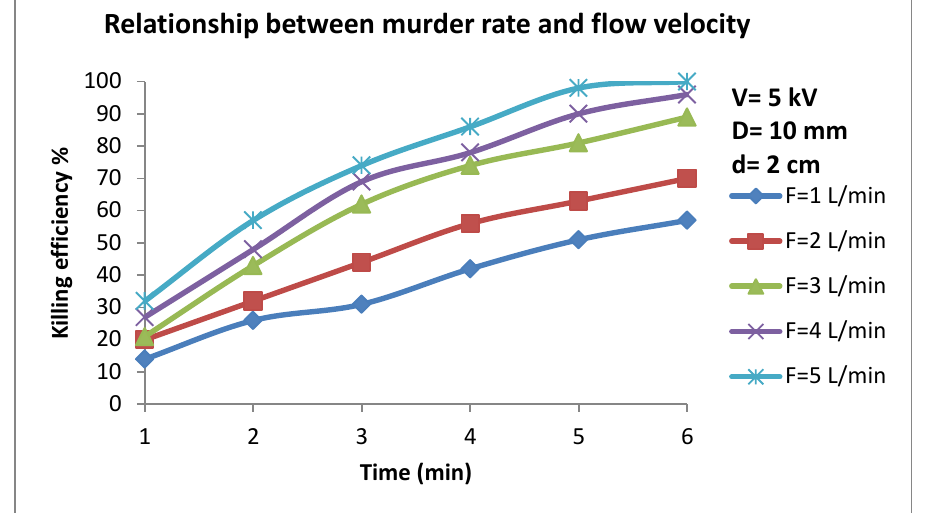
Fig.3: The rate of killing bacteria as a function of time for different gas flow